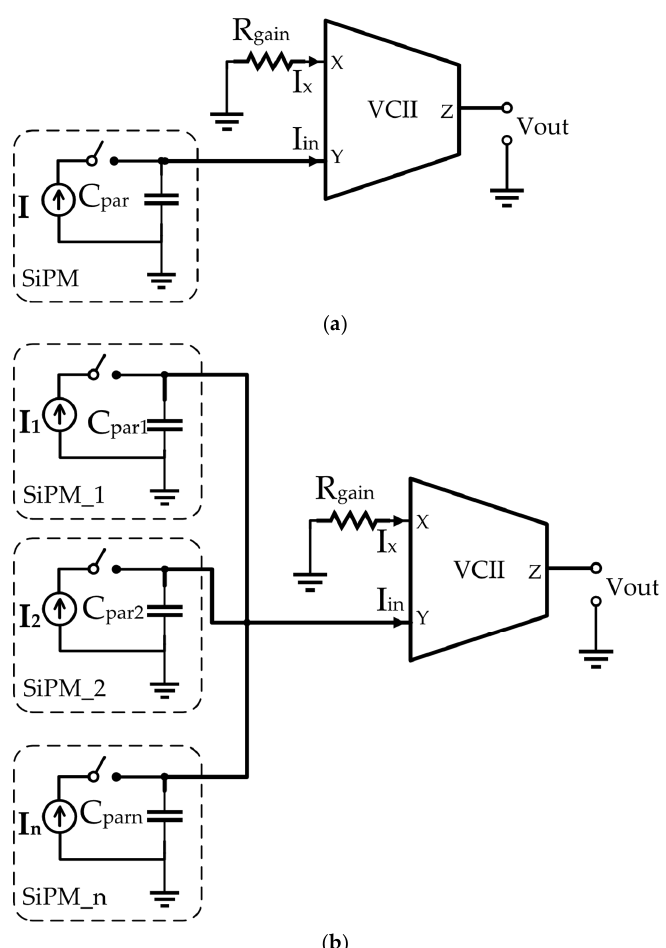
Figure 9. VCII-based readout circuitry for (a) a single SiPM and (b) an array of n SiPMs [13].